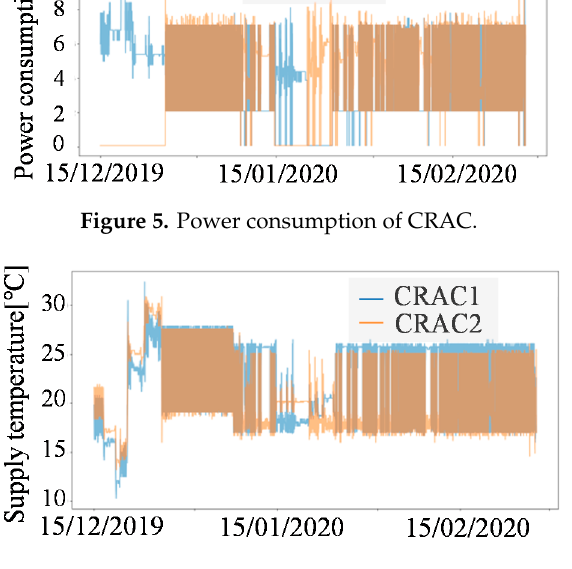
Figure 6. Supply temperature of CRAC.